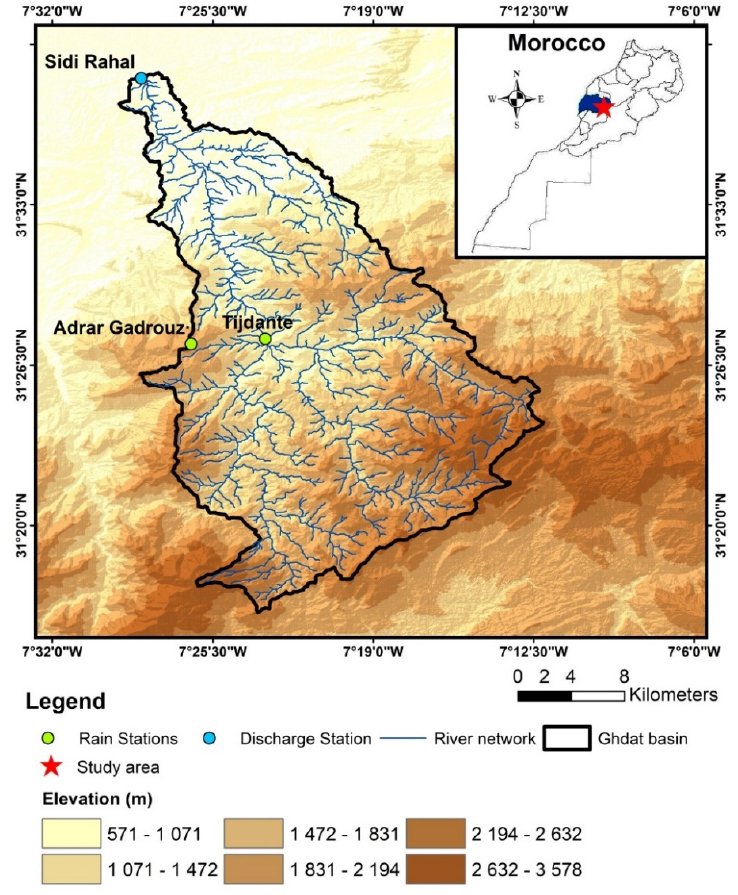
Figure 1. Geographical location of the Ghdat watershed and hydro-rainfall stations.